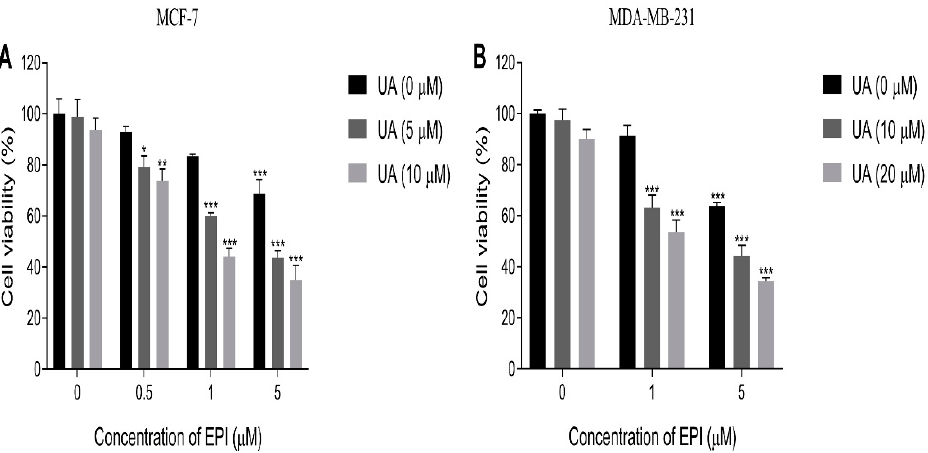
Figure 2. The effects of UA or EPI on cell viability were determined by CCK-8 assay. ( A ) MCF-7 and MDA-MB-231 cells were treated with the indicated concentrations of UA for 24 h. ( B ) MCF-7 and MDA-MB-231 cells were treated with the indicated concentrations of EPI for 24 h. The means and SEM were shown. n = 3. * p < 0.05, ** p < 0.01 and *** p < 0.001 versus cells without drug treatment in the absence of any treatments.